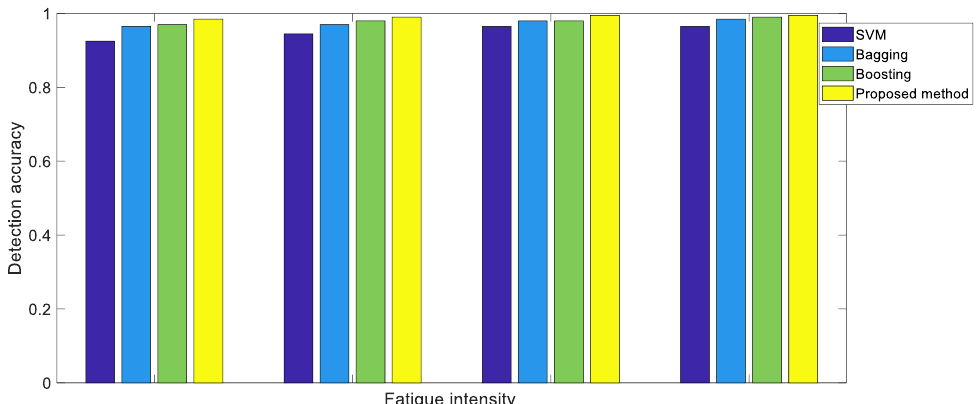
Figure 12. Detection accuracy under different fatigue intensities.